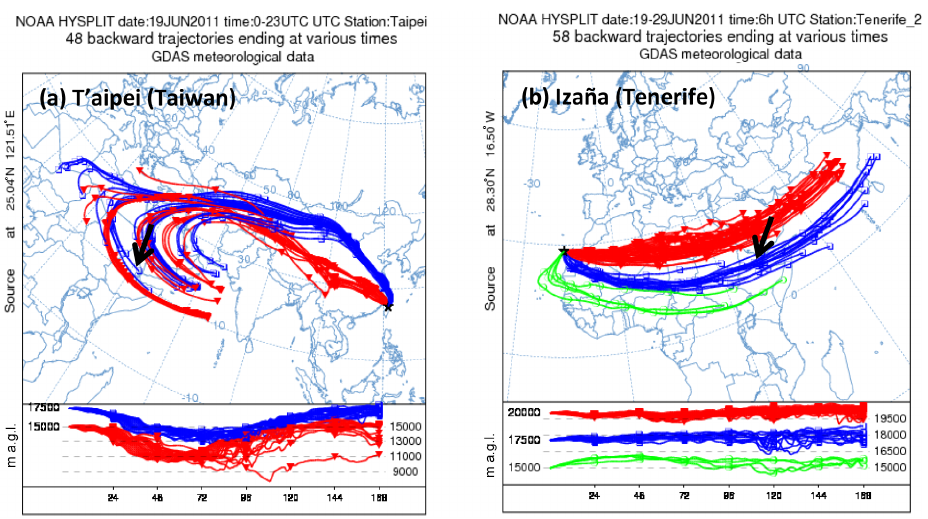
Figure 10. HYSPLIT back trajectories of air masses (a) from T’aipei (Taiwan) on 19 June 2011 and (b) from Izaña (Tenerife) for days 19–29 June 2011. Nabro’s location is indicated by the black arrow.